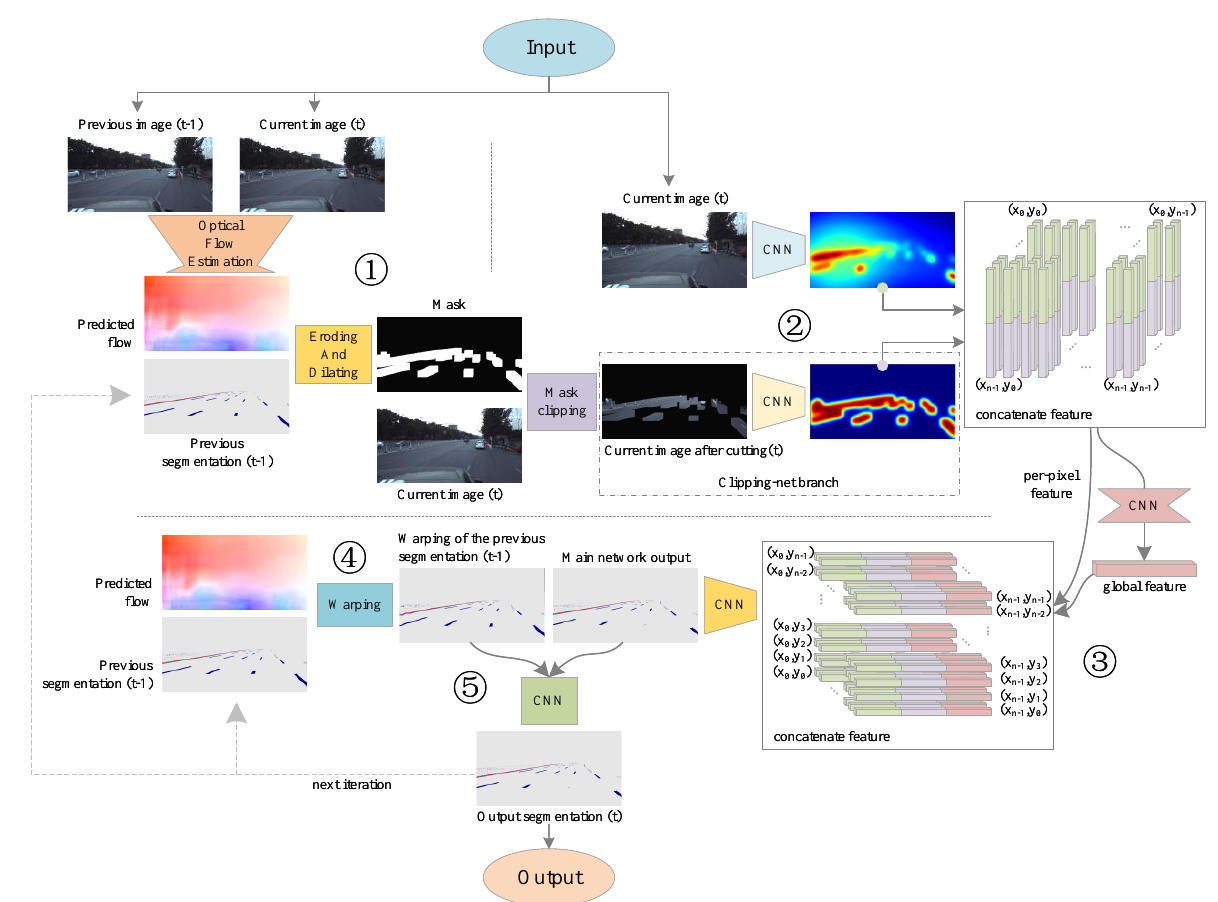
Figure 1. Overview of our model. A mask is generated by the optical flow of adjacent frames to crop the current frame image, and the cropped image and the complete image are used as the input of the main network, which is responsible for the output of the preliminary prediction of the current frame. Then, the optical flow of adjacent frames is used to warp the segmentation of the previous frame to the current frame position, and the distorted segmentation and the output of the main network are used as the input of the optimization network, which is responsible for revising the preliminary prediction of the main network and output the final segmentation of lanes and road markers.